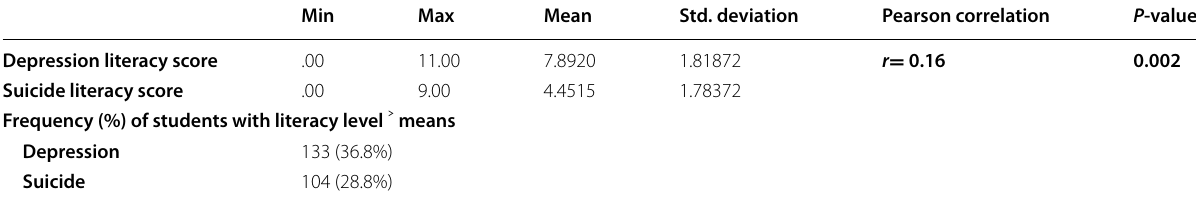
Significance at * p <